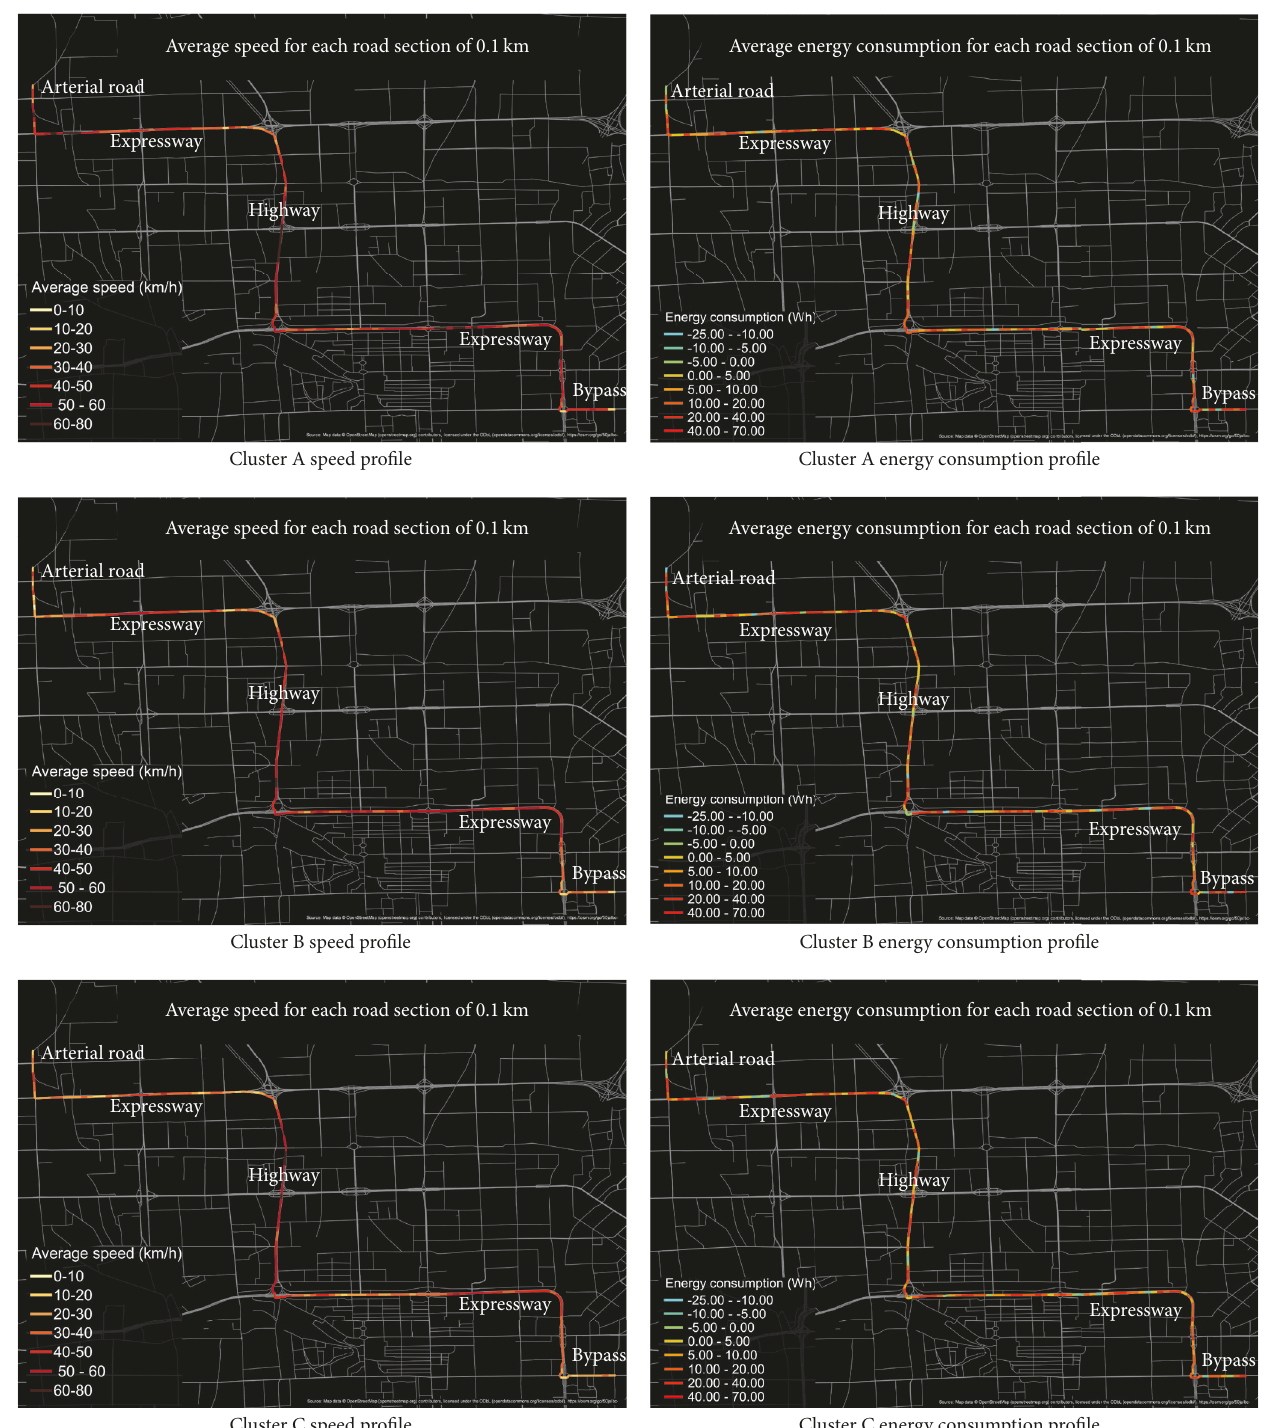
Figure 15: Speed and energy consumption profiles for different clusters in smooth